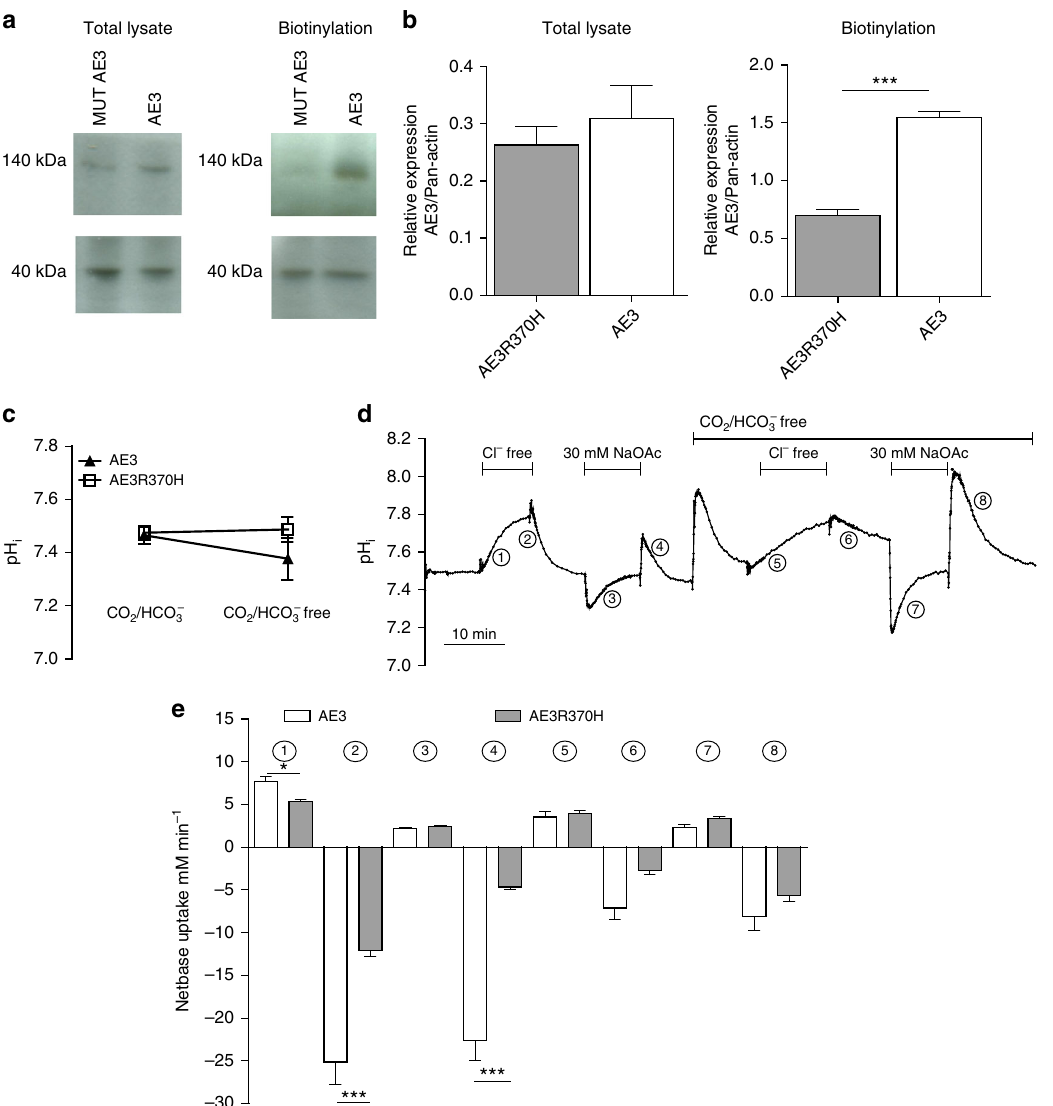
Fig. 2 Immunoblot of AE3 and intracellular pH in HEK-293 cells. a Representative immunoblots of total and membrane localized (biotinylated) AE3 protein in AE3 transfected and AE3 R370H transfected HEK-293 cells. Pan-actin was used as control/reference protein. b Average total and membrane localized AE3 protein relative to pan-actin expression ( n = 4) (* p < 0.05 as determined by unpaired Student t-test). c Steady state pH i of AE3 transfected and AE3 R370H transfected HEK-293 cells in CO 2 /HCO 3 − containing media and CO 2 /HCO 3 − free media. d Representative recording of pH in HEK-293 cells. Numbers indicate parts of the protocols used for calculations of net base transport shown in e . e Average net base uptake for AE3 transfected and AE3 R370H transfected HEK-293 cells. Numbers correspond to the numbers given in c ( n = 7). * p < 0.05, ** p < 0.01, *** p < 0.001 as determined by unpaired Student t- test. Error bars throughout represent the